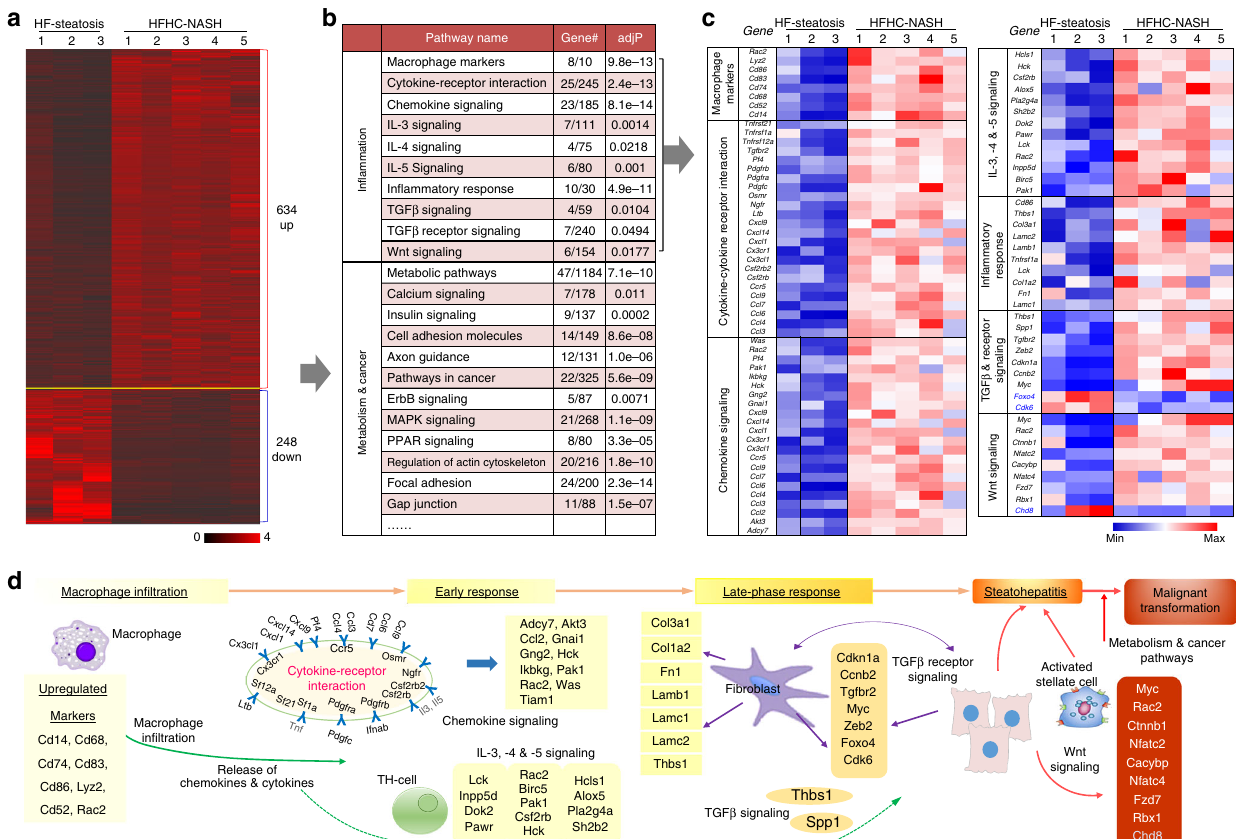
Fig. 2 Expressional aberration of in fl ammation-related genes associated with NASH development in HFHC-fed mice. a Clustering of differentially expressed genes in HFHC-induced NASH as compared to HF-induced steatosis. b Pathways enriched by differentially expressed genes in NASH vs. steatosis. #gene, the number of annotated genes in the input list / number of annotated genes in the reference list. adjP, p value adjusted by multiple test adjustment. c Differentially expressed in fl ammatory genes in NASH compared to steatosis. Expression levels were normalized to the mean level of each gene among all samples shown. d Schematic illustration of the dysregulated pathways involved in the development of HFHC-induced HCCs. Upregulated genes included two cell adhesion molecules ( ALCAM and ITGA6 ), 3 MAPK signaling genes ( DDIT3 , MAP3K6 and PAK1 ) and 6 other metabolic genes ( ALDH18A1 , CAD , CHKA , POLD4 , PSPH , SQLE ). Differential expression of seven of these genes ( CFD , ALDH18A1 , CHKA , DDIT3 , ITGA6 , PSPH and SQLE ) was replicated in another set of 12 paired NASH-HCCs and adja- cent non-tumor livers by RT-qPCR (all P < 0.05 by paired t test;